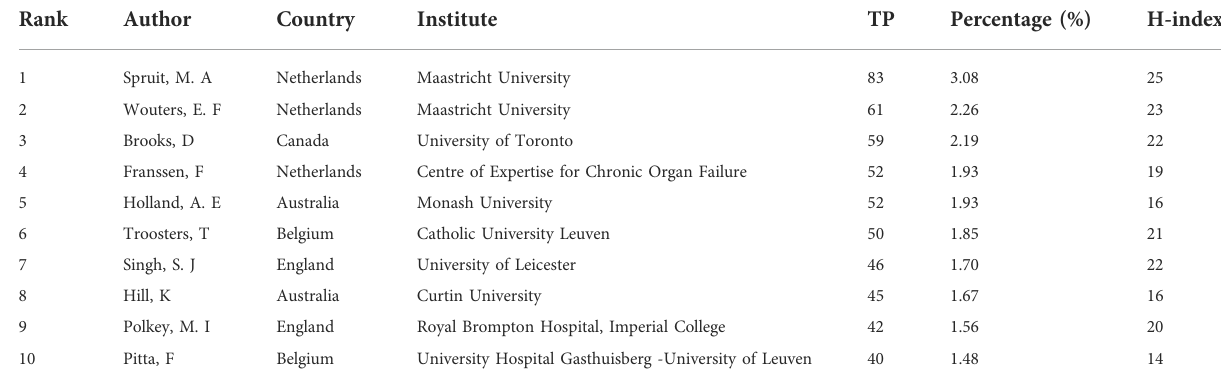
TABLE 2 Top 10 authors in the studies of COPD and exercise therapy.